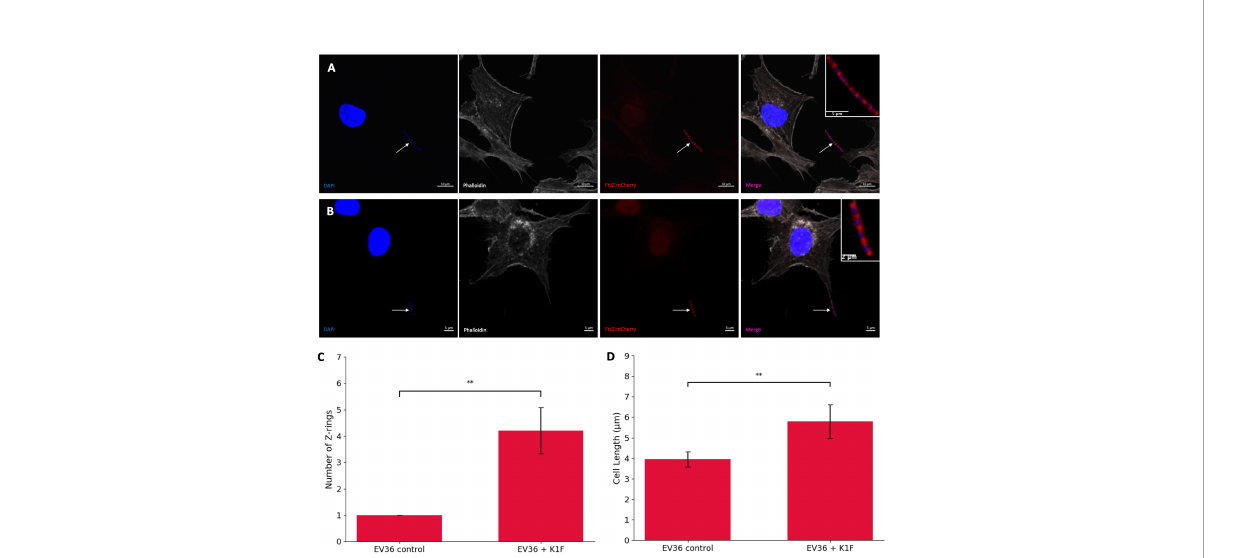
FIGURE 4 K1F phage inhibition of FtsZ in K1 Escherichia coli . (A, B) Fluorescent images of EV36/FtsZ-mCherry cells after K1F-GFP phage infection fi xed in a human cell model. Arrows point to fi lamentous cells. DAPI stain is shown in blue, phalloidin in grey, and FtsZ-mCherry in red. (C, D) Quanti fi cation of Z-ring number and cell length for 75 EV36/FtsZ-mCherry bacterial cells infected with K1F-GFP phage and compared to a no- phage control. Averages plotted with error bars showing one standard deviation of uncertainty. Tukey ’ s tests were performed, and the calculated probability values (p-values) are displayed as p < 0.01